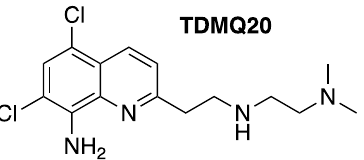
Figure 1. Structure of TDMQ20 copper chelator.